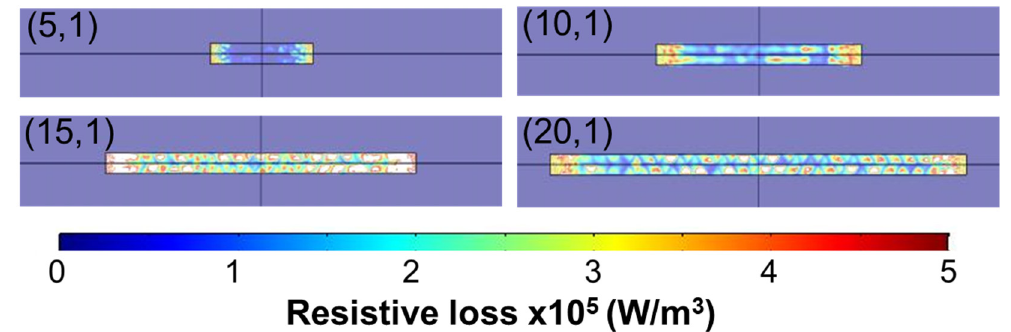
Figure 8. Simulation of resistive loss around bulk silver against the direction of conveying the samples in the TM 110 cavity: (width, length) = (5 mm, 1 mm), (10 mm, 1 mm), (15 mm, 1 mm), and (20 mm, 1 mm) bulk silver with 8 µm of thickness, respectively.